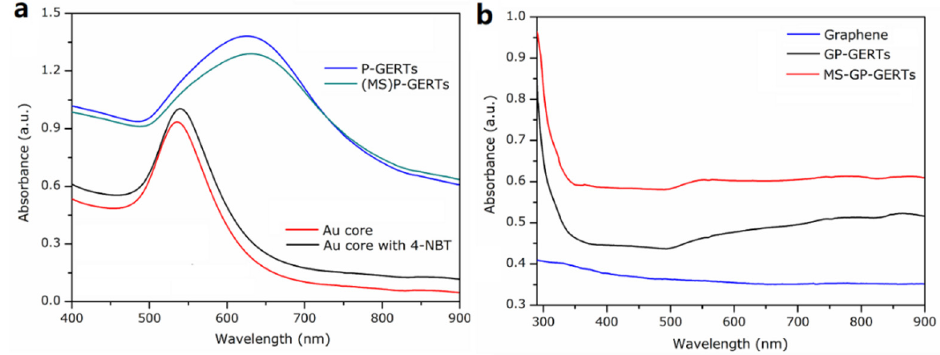
Figure 2. UV-Vis Absorption Spectroscopy: ( a ) absorption spectroscopy of gold core, gold core modified Raman molecule, P-GERTs, and (MS) P-GERTs; ( b ) UV-Vis absorption spectroscopy of graphene, GP-GERTs and MS-GP-GERTs.